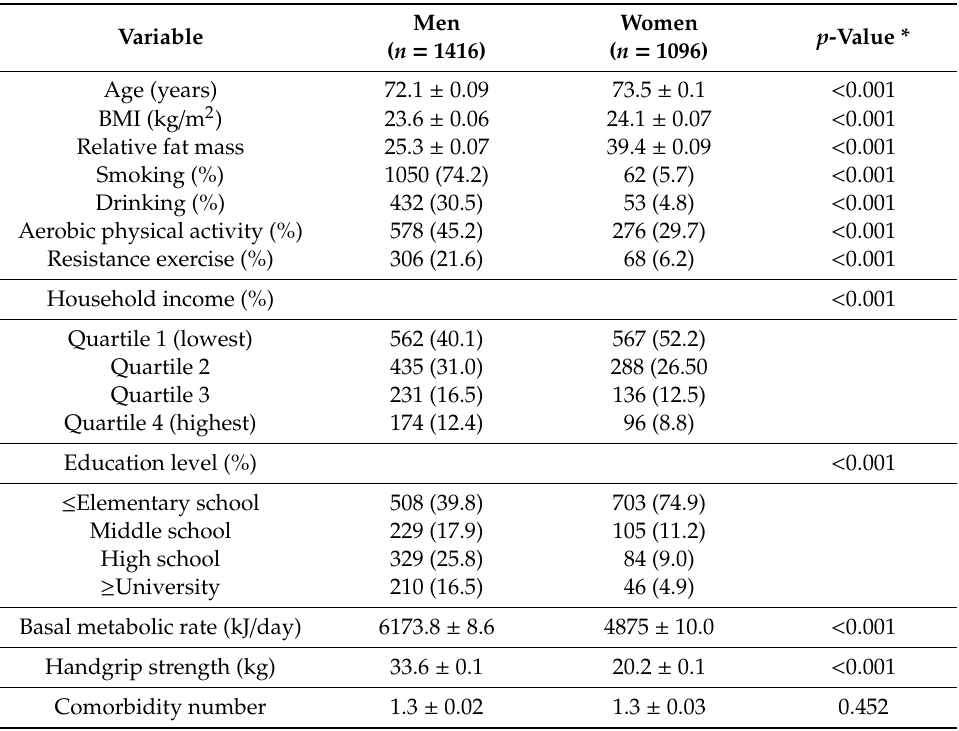
Table 1. Clinical characteristics of study